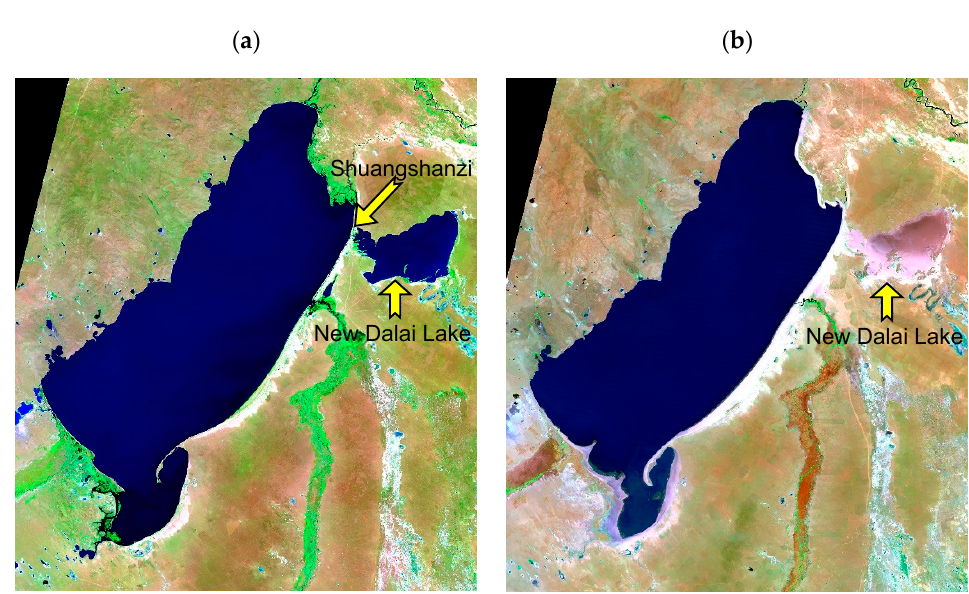
Figure 3. Location and status of New Dalai Lake in different periods (false color synthesis of remote- sensing images): ( a ) 2000, and ( b ) 2007.